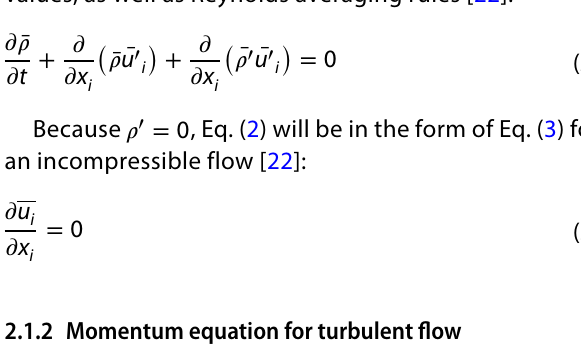
Fig. 3 General geometry for simulation (or the domain of the prob- lem)